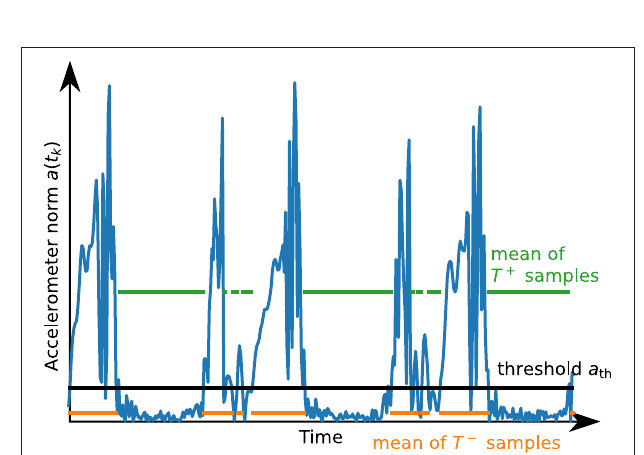
FIGURE 6 | Illustration of the result of the automatic thresholding algorithm for a short segment of accelerometer data. The threshold a th is chosen such that the mean of the values above and the mean of the values below are in a certain